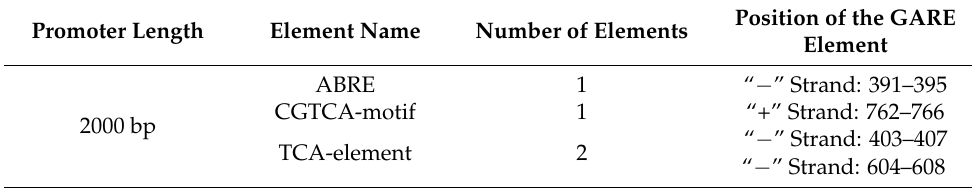
Table 1. Information on NoMYB60